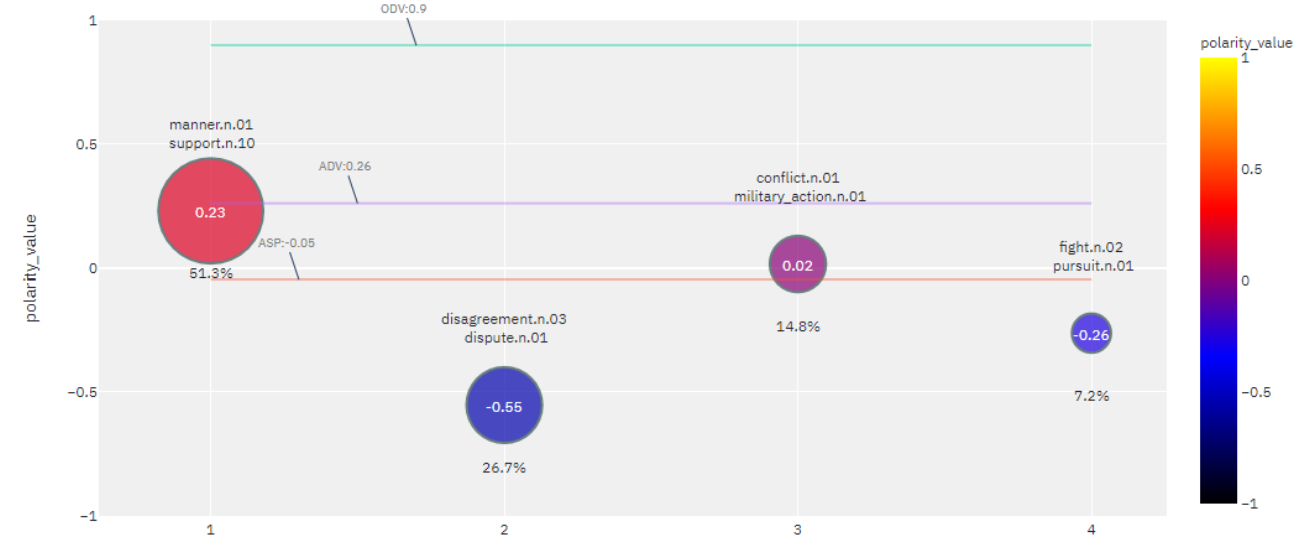
Figure 4. Sentiment potential ( SP ) of lexeme fight-n calculated with SenticNet 6 polarity-value; propagated on pruned graph clusters of 15 best ranked collocates in the first degree and 15 collocates in the second degree within ententen13 corpus.